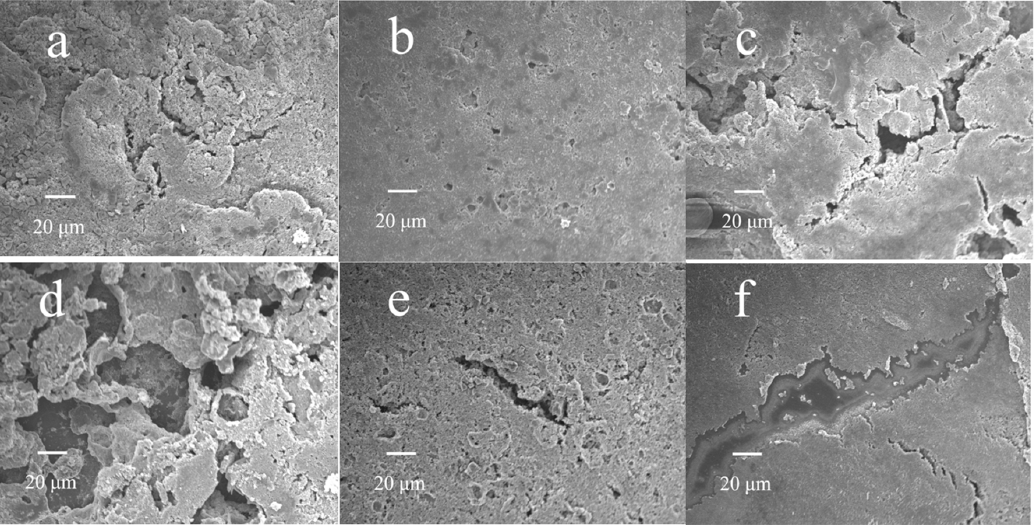
Figure 6. SEM images of cycled electrodes with ( a ) PVDF, ( b ) γ -PGA, ( c ) PVP, ( d ) CMC, ( e ) PAN, and ( f ) PEO.